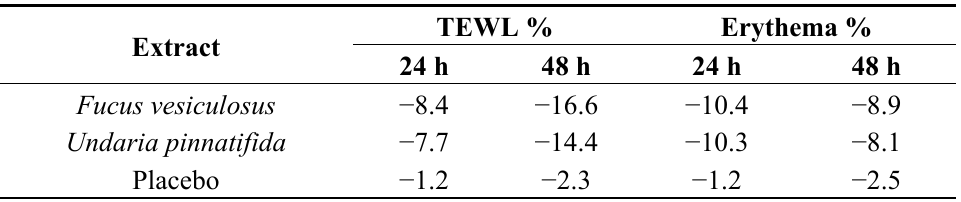
Table 11. Erythema and TEWL Study Scheme 2, as compared to control ( n = 25) (percent change of mean vs. control).